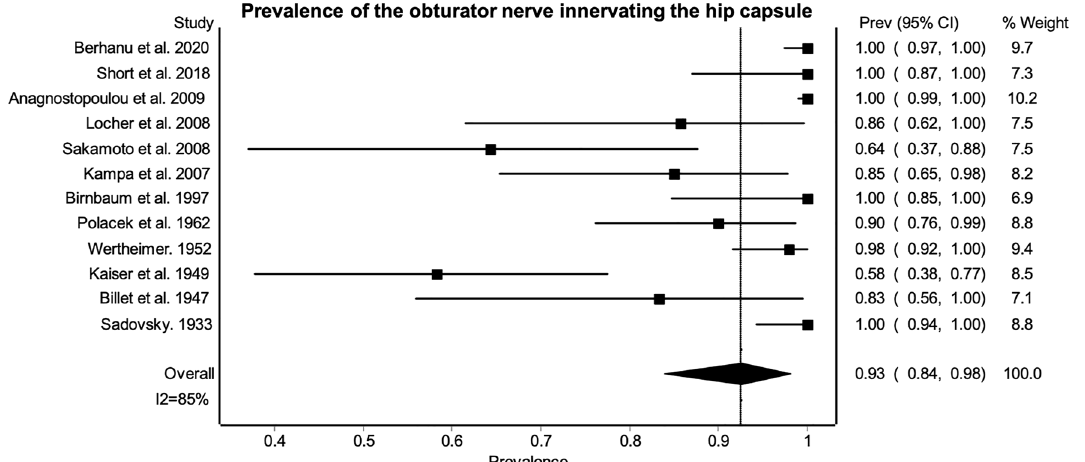
Figure 2. Prevalence of the obturator nerve innervating the hip capsule. Results indicate the variation in prevalence across studies with 95% confidence intervals. There is high heterogeneity between studies as shown by the I 2 statistic of 85%.